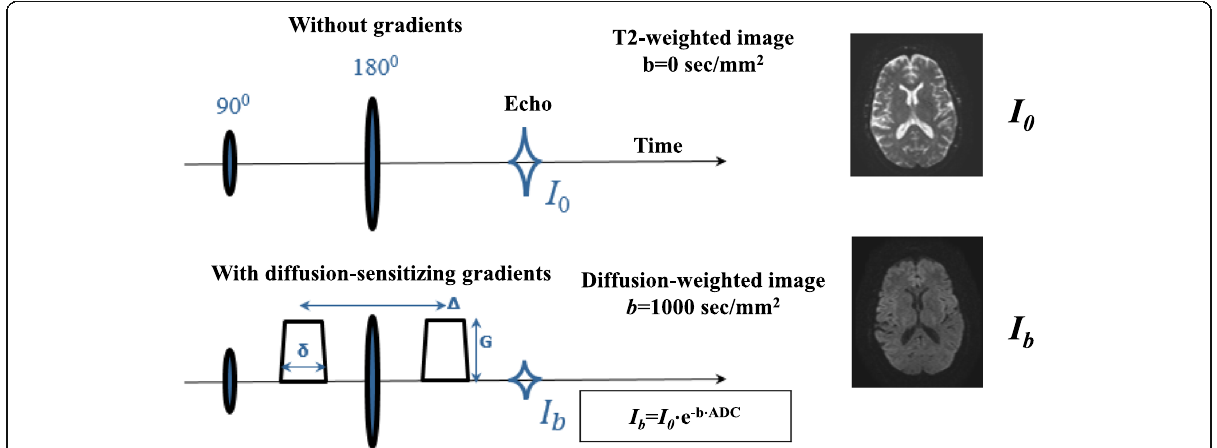
Fig. 1 Timing diagram and main characteristics of a diffusion-weighted pulse